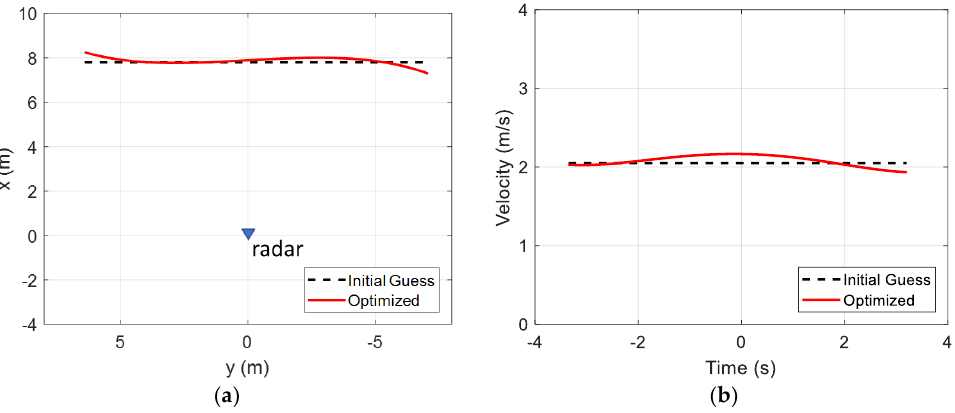
Figure 9. Drone in-flight fitted position and velocity. ( a ) Position; ( b ) Velocity.